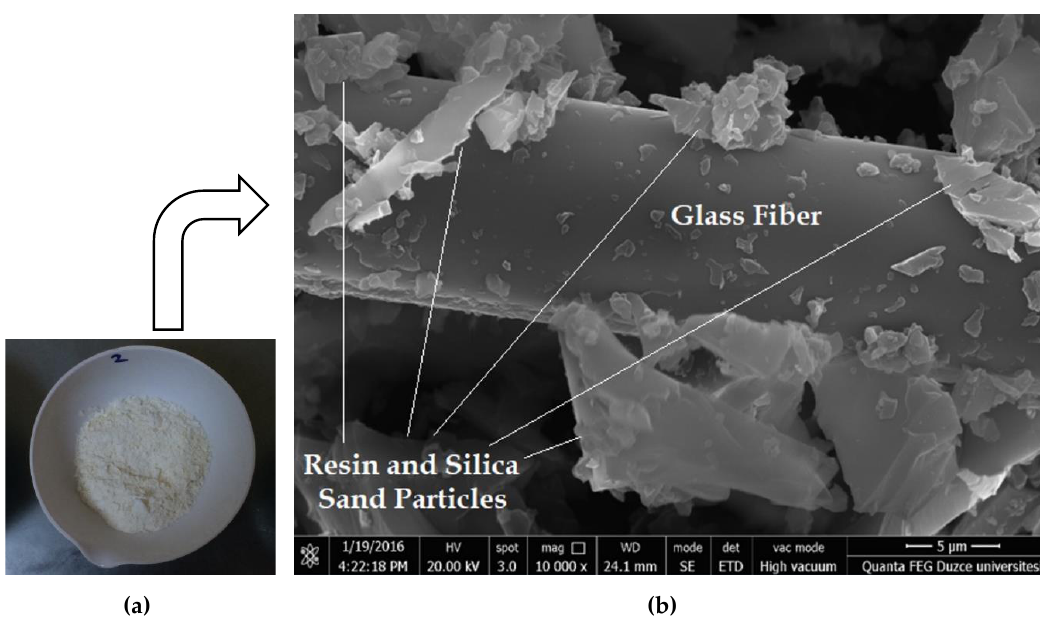
Figure 2. ( a ) GRP-WP and ( b ) SEM image of GRP-WP.